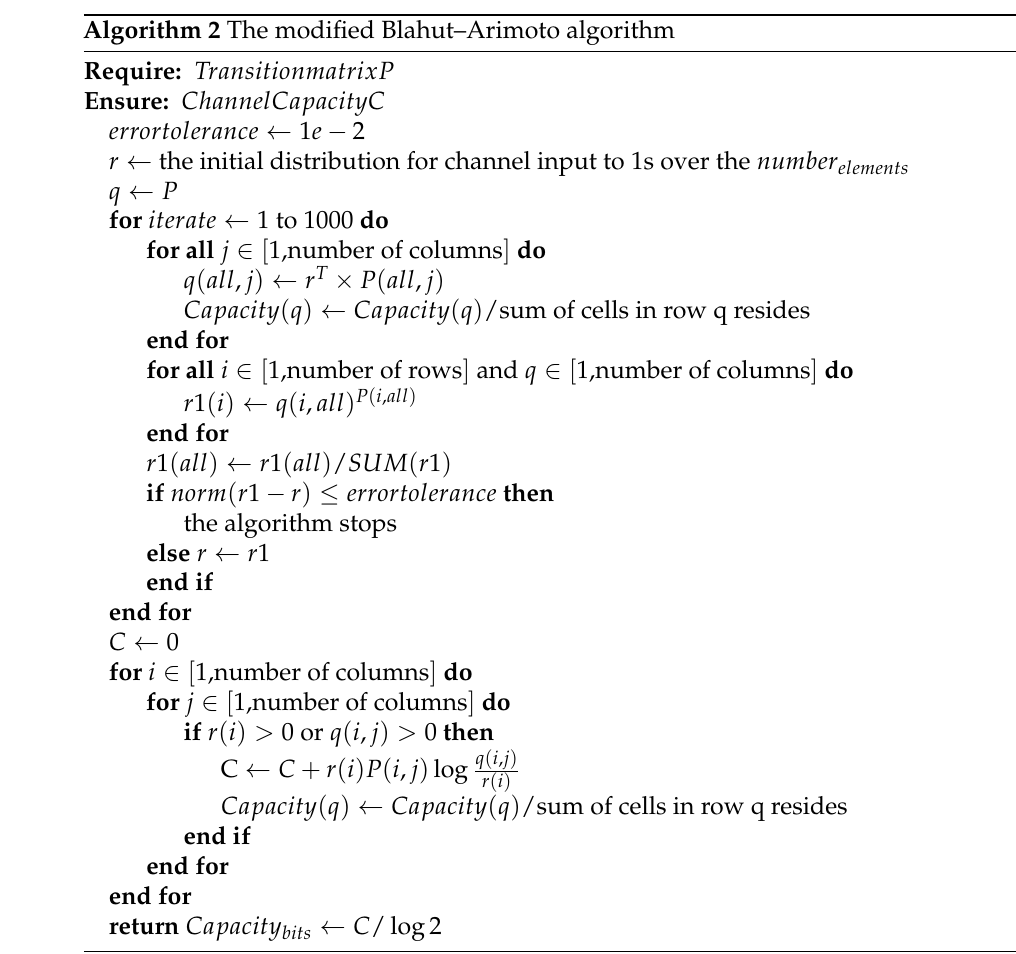
Algorithm 2 The modified Blahut–Arimoto